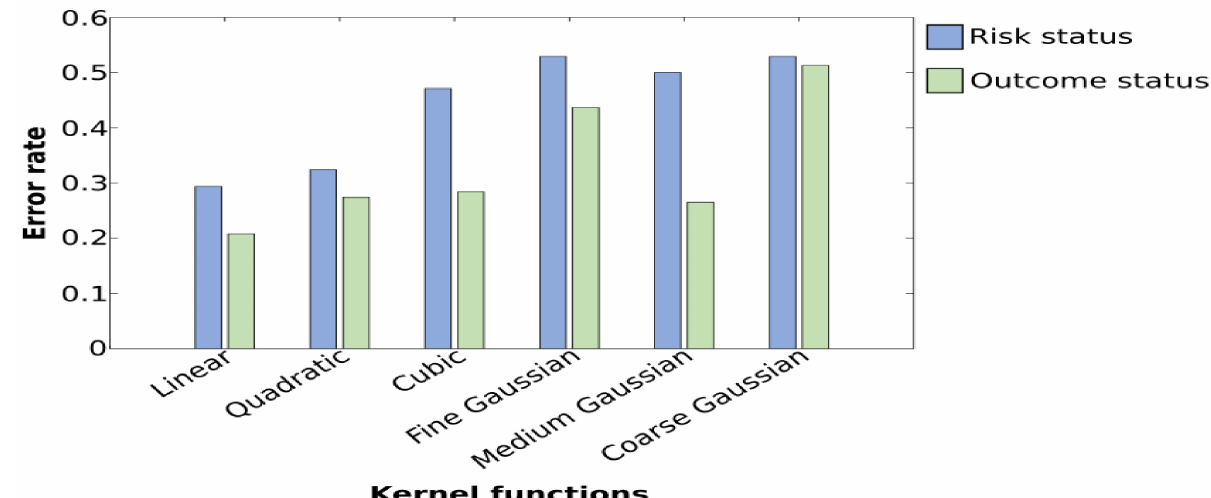
Figure 5. Plot of error rates of the testing set obtained while employing different kernel functions. Graphs show that for the classification of the risk group and outcome status, a minimal error rate is obtained with linear SVM. A maximal error rate is obtained with coarse Gaussian SVMs when classifying risk status and with the fine Gaussian and coarse Gaussian when classifying the diagnosis outcome.